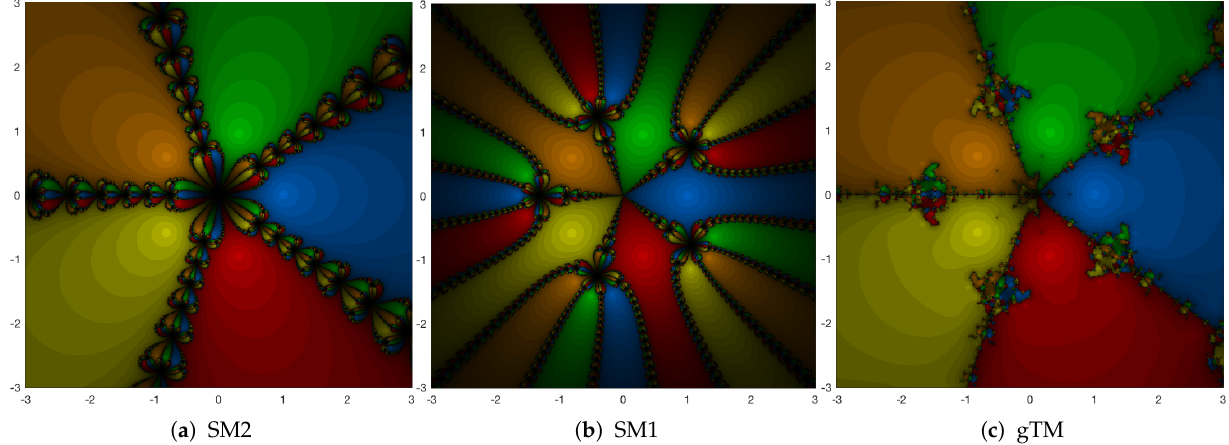
Figure 6. Dynamical planes of Schröder methods and gTM on f 4 ( x ) .